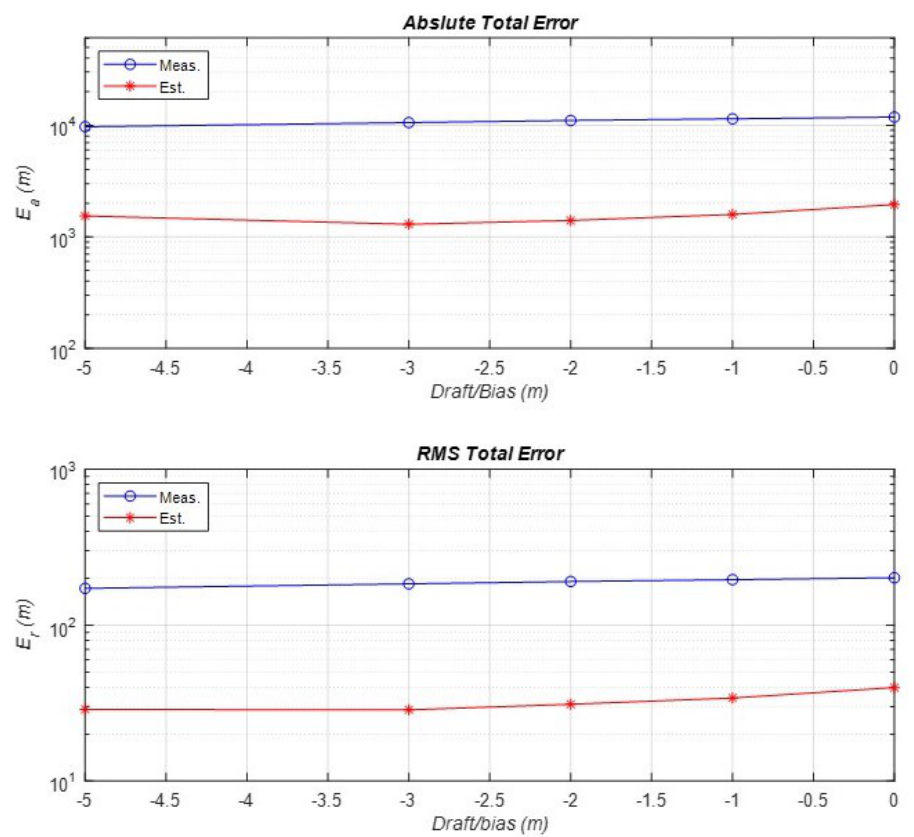
Figure 10. Absolute and RMS total meaured errors (blue lines), and absolute and RMS total estimated errors (red lines) related to the draft (or bias) of the echosounder from sea-surface level at a constant grid range and beam